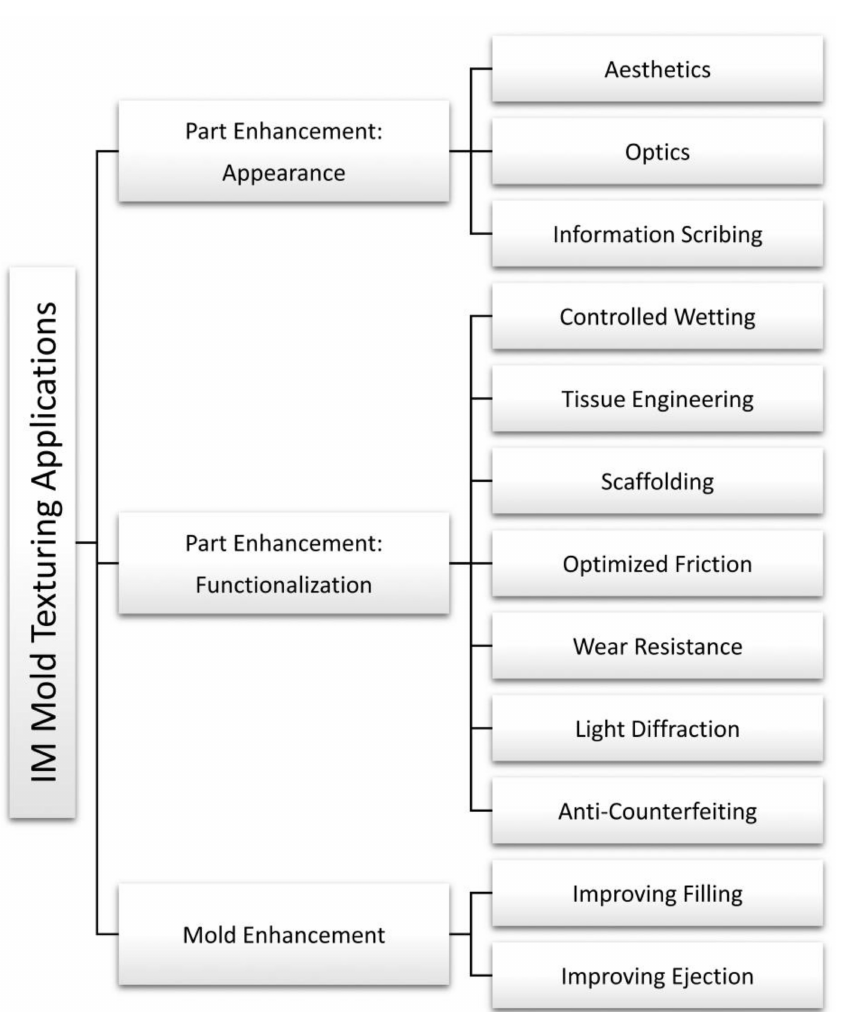
Figure 16. Applications of surface texturing in injection molding and their